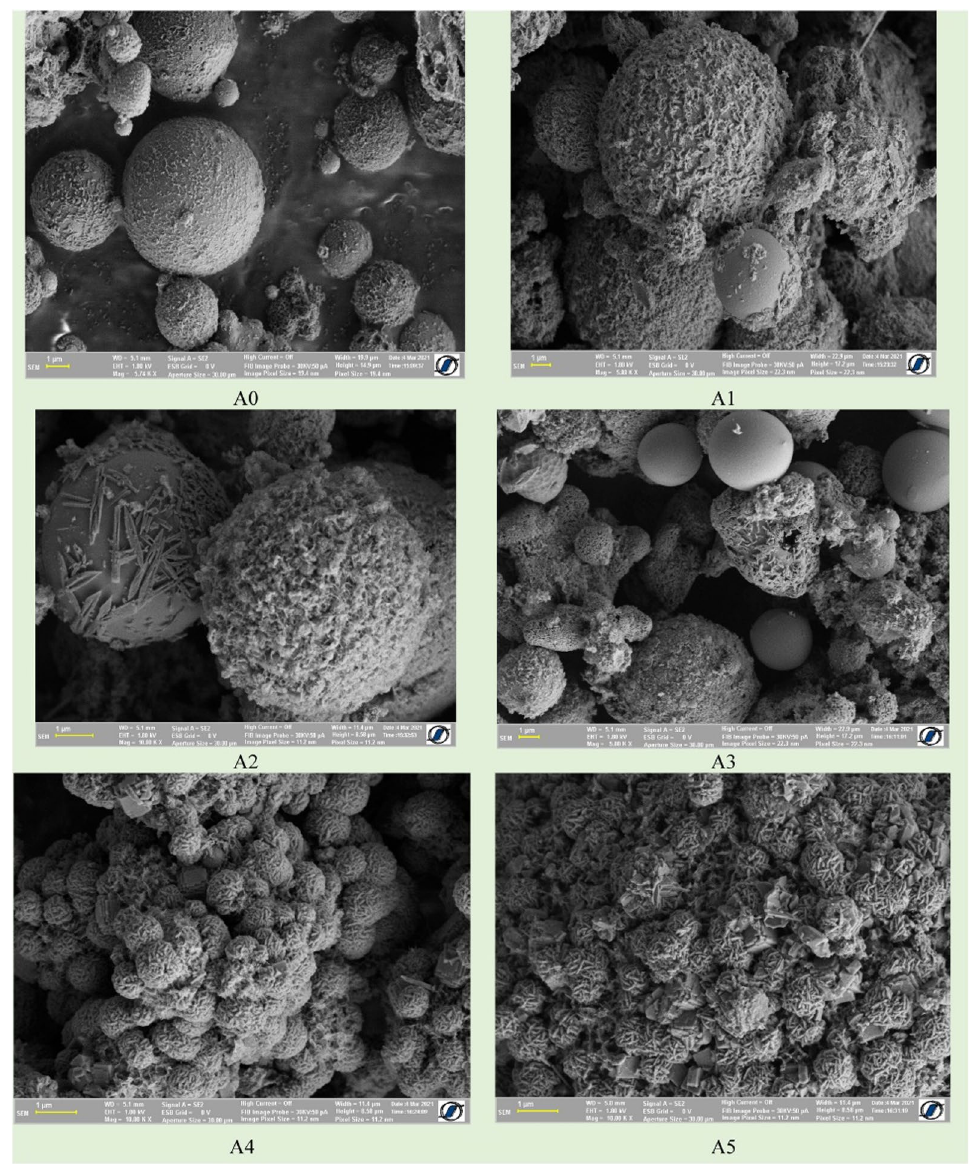
Fig. 20 SEM pictures of untreated and treated CFA (Buema et al.